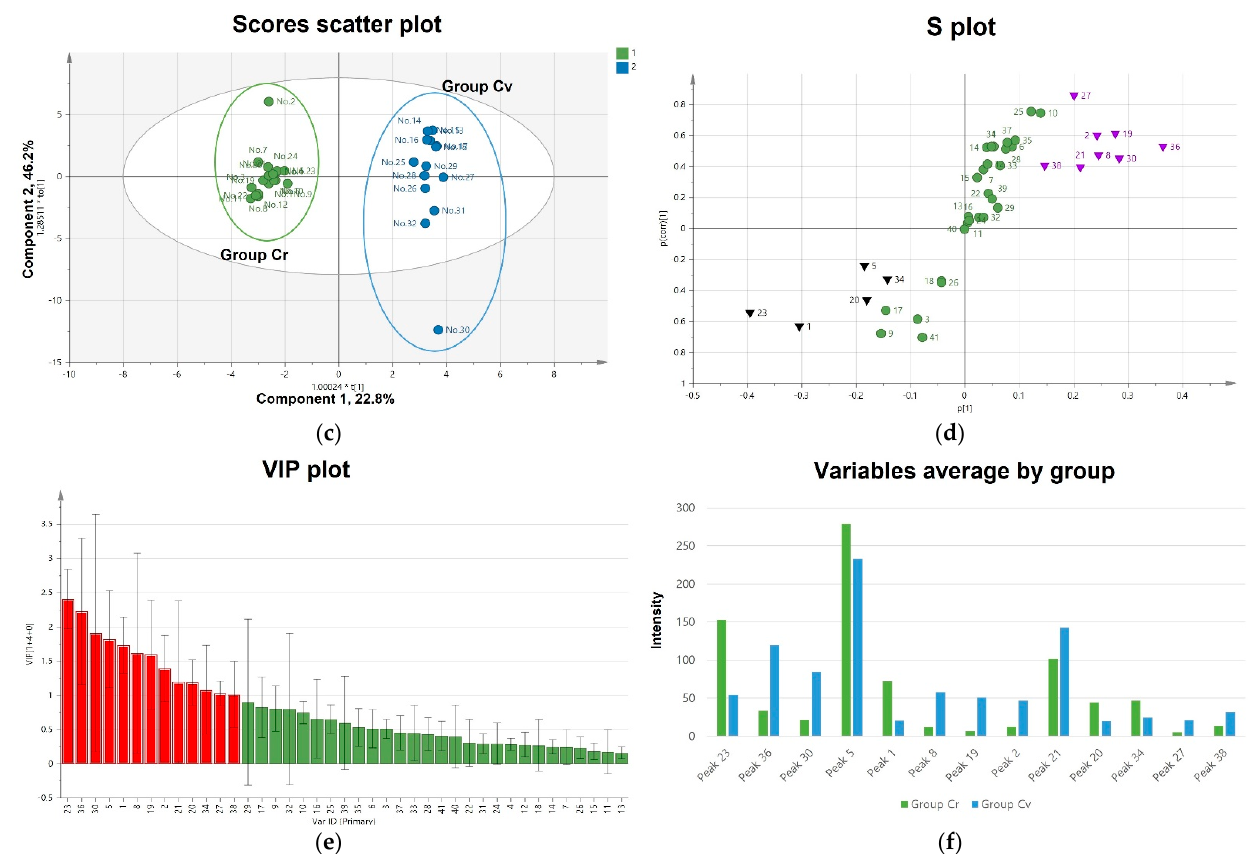
Figure 2. Principal component analysis (PCA) ( a ) score plot and ( b ) loading plot of metabolome analysis of the 32 Coreopsis cultivars; orthogonal partial least-squares discriminant analysis (OPLS-DA) ( c ) score plot and ( d ) S-plot show selected markers for differentiating Coreopsis rosea and Coreopsis verticillata ; ( e ) Variable importance plot (VIP) scores of selected markers; ( f ) variables averages by group of selected potential marker compounds.